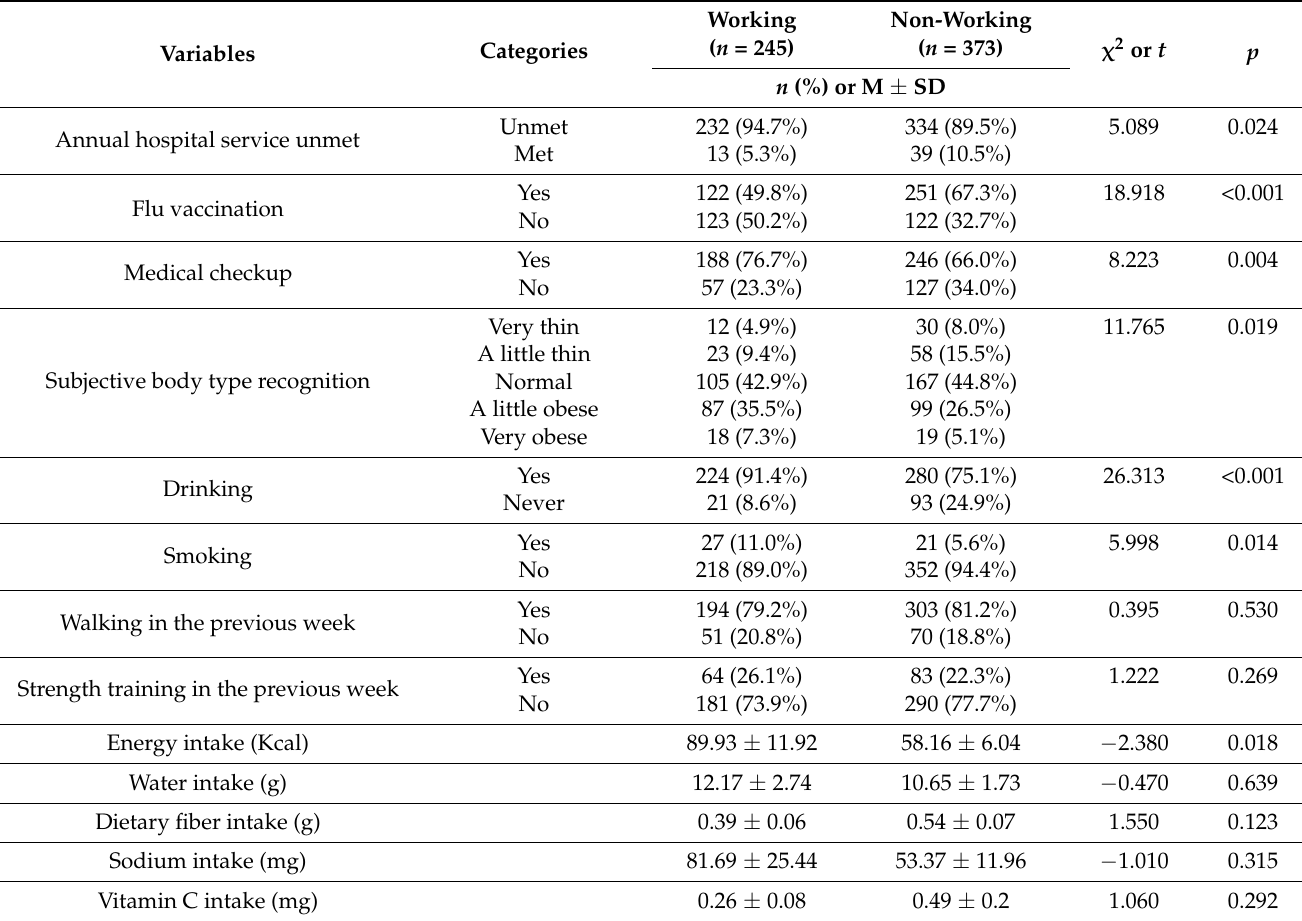
Table 2. Health behavior-related variables depending on the occupational status, n = 618.